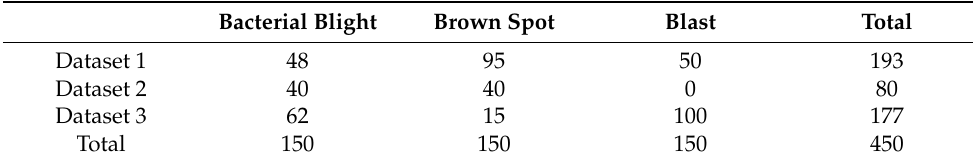
Table 1. Dataset structure.